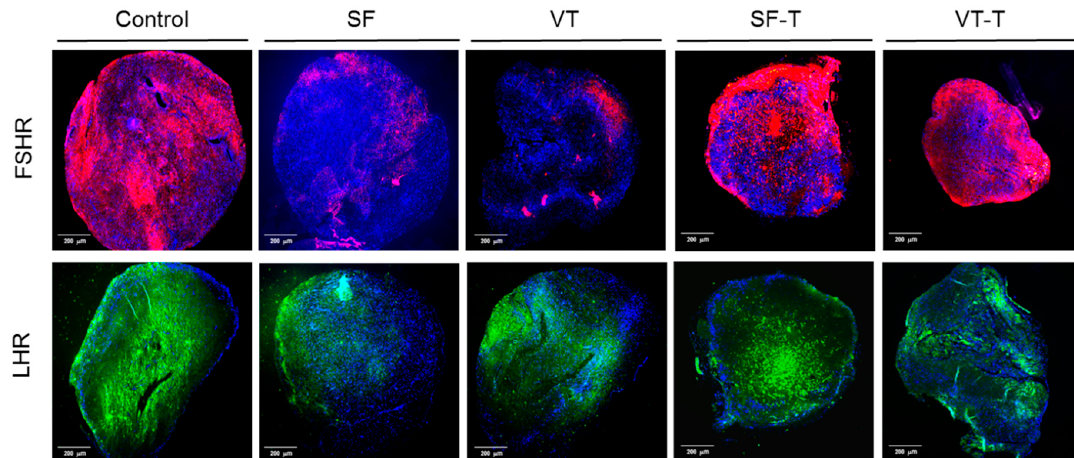
Figure 4. Immunofluorescence staining of ovarian tissues with follicle stimulating hormone receptor (FSHR) and luteinizing hormone receptor (LHR). Positive area for those receptors are shown as red and green, respectively. The FSHR-positive area and LHR-positive area were higher in the transplanted tissue group (SF-T and VT-T) than those in the freezing group (SF and VT). Among the engrafted tissues, the SF-T group displayed a higher proportion of FSHR-positive area compared to the VT-T group. Abbreviations: FSHR, follicle stimulating hormone receptor; LHR, luteinizing hormone receptor; SF, cryopreserved with slow freezing technique and thawed group; VT, cryopreserved with vitrification technique and thawed group; SF-T, the group xenotransplanted after slow freezing and thawing; VT-T, the group xenotransplanted after vitrification and thawing.